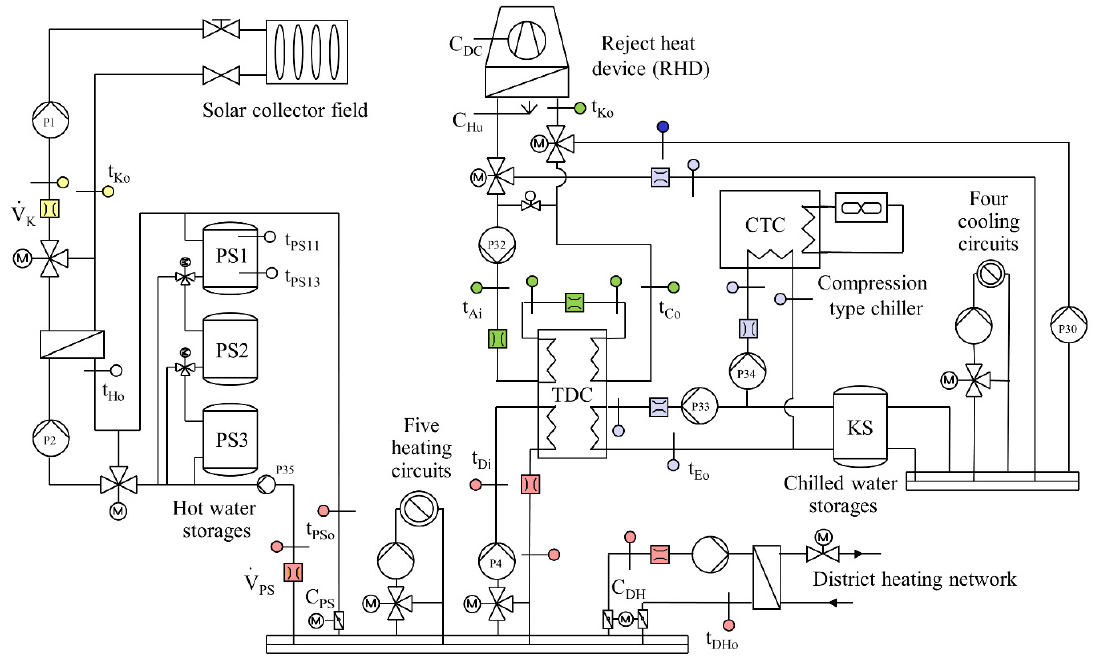
Figure 1. Simplified process and instrumentation diagram of the SAC system at the Federal Environmental Agency (UBA) in Dessau, Germany. Only the temperature probes and flow meters that are used in the result section are labelled.